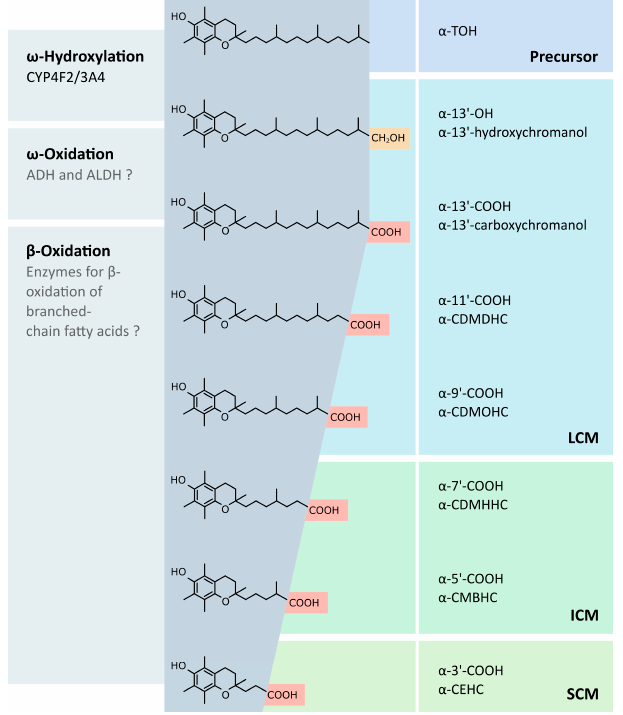
Figure 1. Metabolism of vitamin E. The metabolism of vitamin E is initiated by a terminal ω -hydroxylation of the side-chain via CYP4F2 and CYP3A4. The resulting hydroxychromanol is